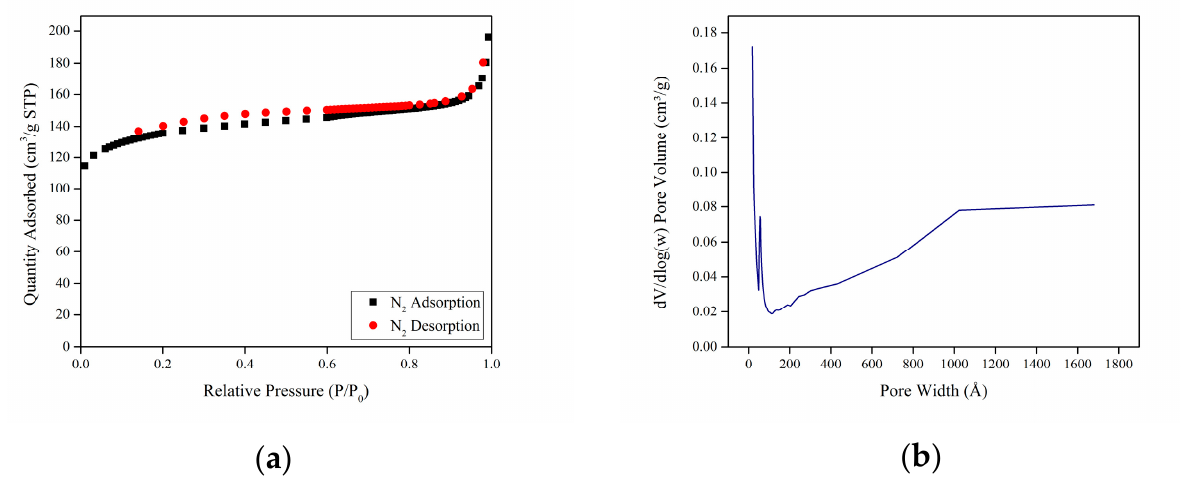
Figure 5. ( a ) N 2 adsorption-desorption isotherms; ( b ) BJH pore size distribution of Mg-gallate.